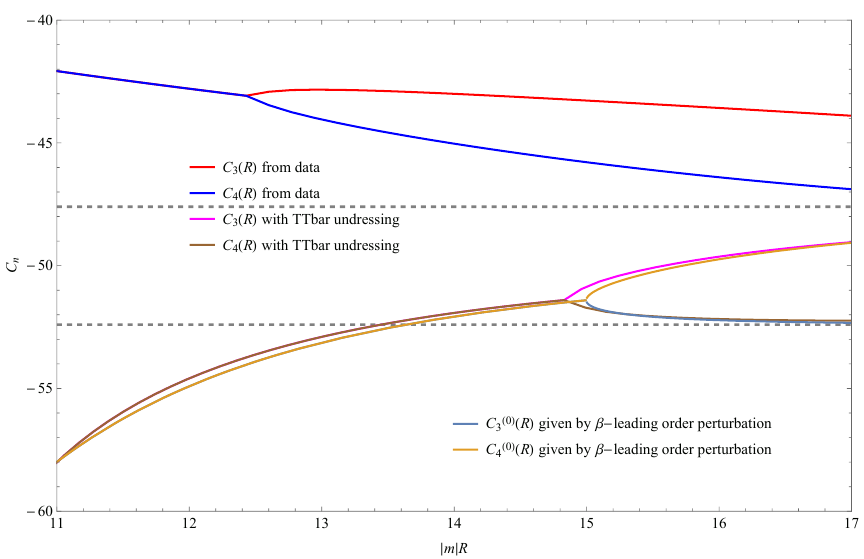
Figure 12 . Same as in figure 11, but now light blue and light brown show eigenvalues of the matrix